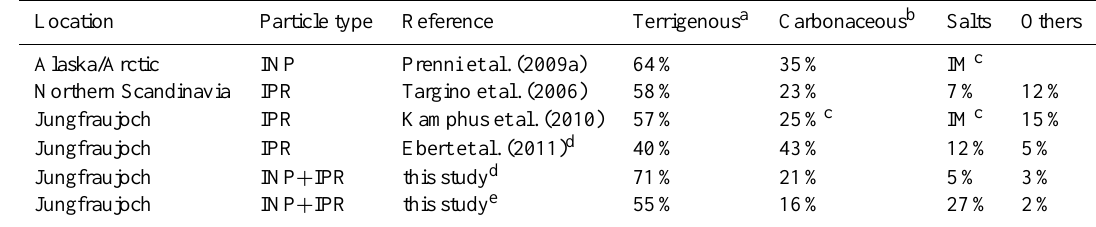
Table 4. Average INP/IPR composition encountered in mixed-phase clouds for several field experiments. Location Particle type Reference Terrigenous a Carbonaceous b Salts Others Alaska/Arctic INP Prenni et al. (2009a) 64% 35% IM c Northern Scandinavia IPR Targino et al. (2006) 58% 23% 7% 12% Jungfraujoch IPR Kamphus et al. (2010) 57% 25% c IM c 15% Jungfraujoch IPR Ebert et al. (2011) d 40% 43% 12% 5% Jungfraujoch INP + IPR this study d 71% 21% 5% 3% Jungfraujoch INP + IPR this study e 55% 16% 27%